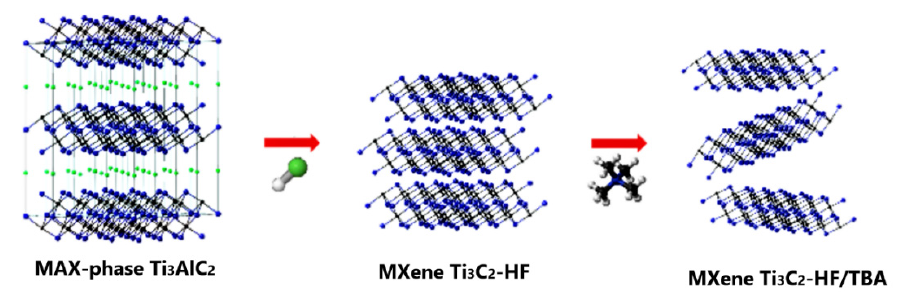
Figure 21. Schematic illustration of the Ti 3 AlC 2 exfoliation. Reprinted with permission from [123]. Copyright © 2020, American Chemical